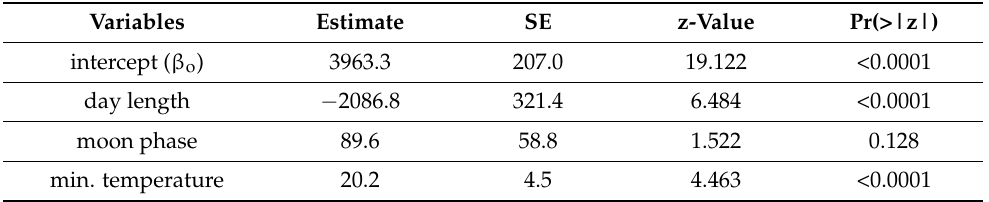
Figure 6. ( a ) Diel activity pattern of two male and two female wildcats based on ODBA values on a 24 h basis ( b ) Diel activity pattern of a female wildcat (Ira) during non-denning (October–March) and denning (April–June) periods, based on ODBA values on a 24 h basis. Table 3. Model averaged estimates and significance of the environmental variables predicting wildcat 24 h activity, as measured in ODBA (daily mean of hourly